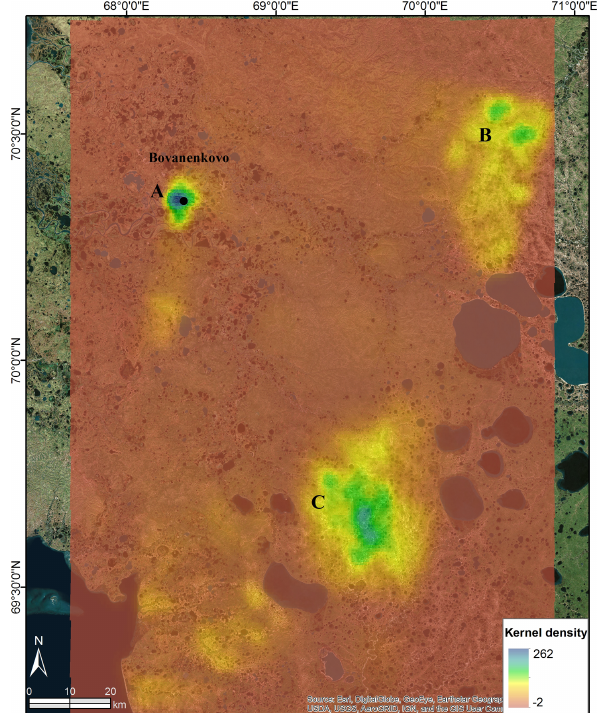
Figure 1. Results of PS InSAR analysis, colors show spatial pattern of seasonal subsidence velocity for June–October 2017–2018.